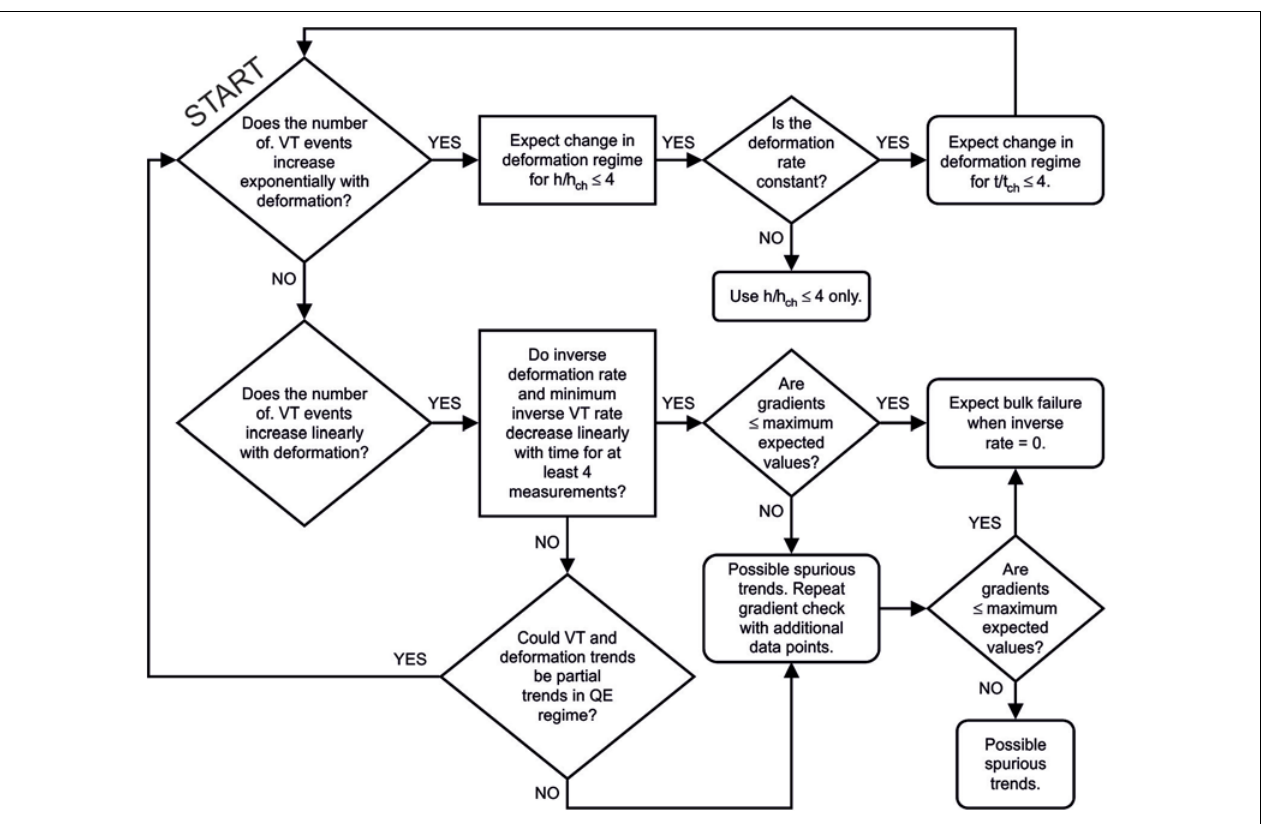
FIGURE 9 | Flow-chart showing an example the proposed operational procedure for applying the elastic-brittle model to VT and deformation signals of unrest. It assumes a transition from exponential to hyperbolic VT event rates after an amount of ground movement 4 h ch and, for a constant rate of stress supply, after a time 4 t ch